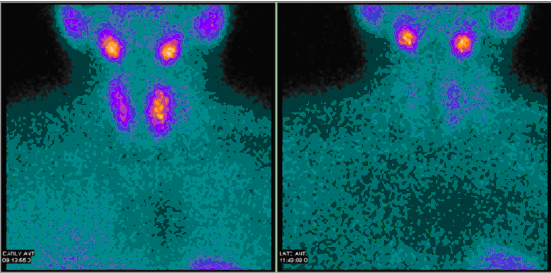
Figure 1. Parathyroid 99mTc sestamibi scan (MIBI scintigraphy) - increased accumulation of tracers in the middle and bottom of the left thyroid thirds